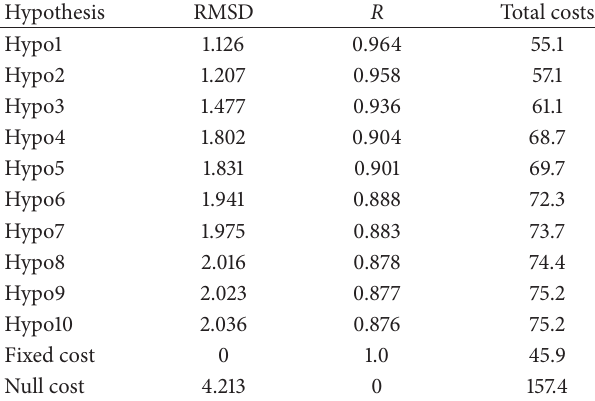
Table 5: Output parameters of the 10 generated PH4 Hypotheses after CatScramble validation procedure for TMPK mt inhibitors listing RMSD, total cost and R correlation